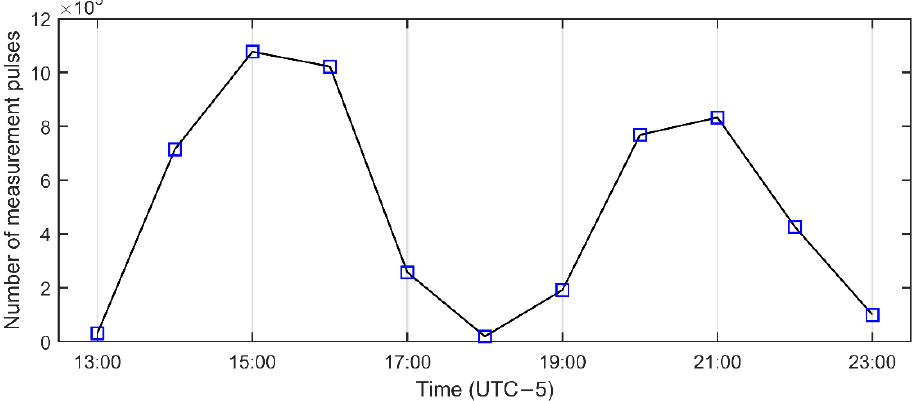
Figure 13. Number of lidar pulses performed at various periods in the Gulf of Mexico.